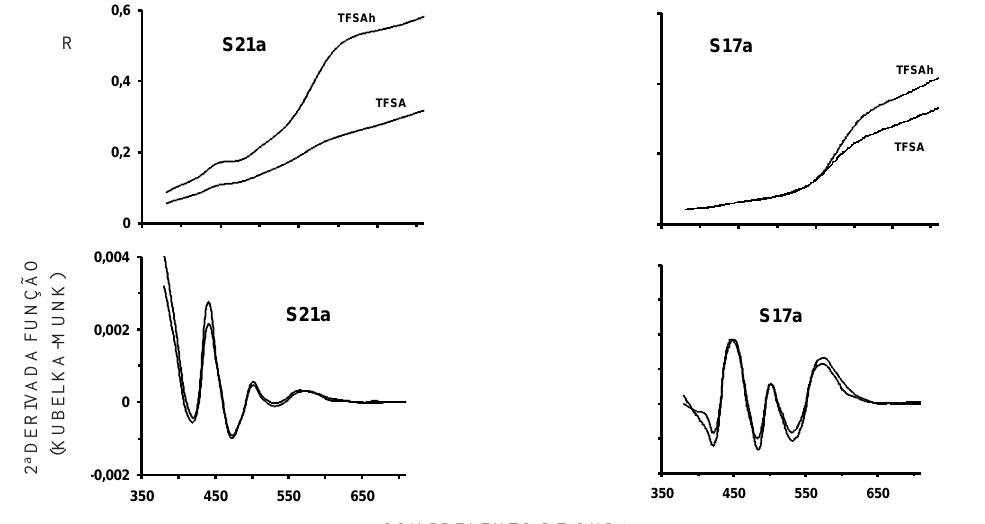
COMPRIMENTO DE Figura 5. Espectros de refletância difusa (R) e correspondente segunda derivada da função Kubelka- Munk (f(KM)) da terra fina seca ao ar (TFSA) e terra fina tratada com hipoclorito para remoção da matéria orgânica (TFSAh) das amostras S17a (LV) e S21a (LVA).